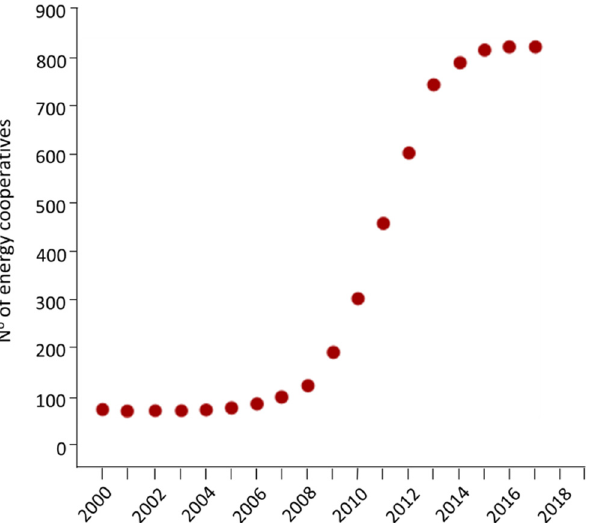
Figure 4. Evolution of the number of energy cooperatives in Germany between 2000–2017. Source: Adapted from [124].